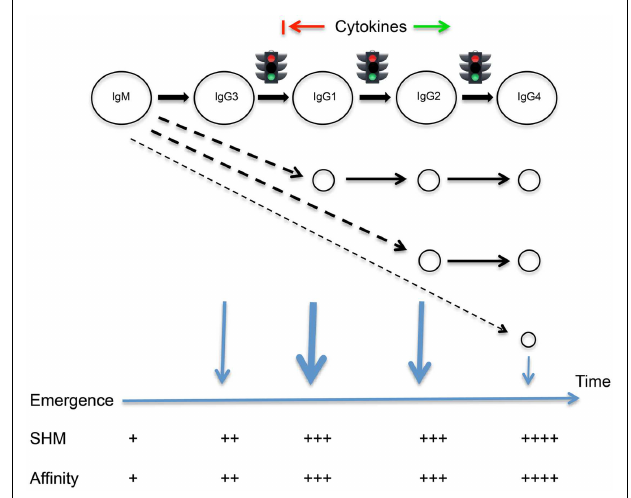
FIGURE 1 |TheTemporal Model of IgE/IgG class switching and departure from the germinal center reaction . A programed sequence of sequential switching is highlighted, though alternative switch pathways are also indicated.The timing of switching events and the emergence of different cell types from the germinal center reaction is suggested by the extent of somatic point mutations carried by the cells. Many cytokines may act to promote or delay class switching, as